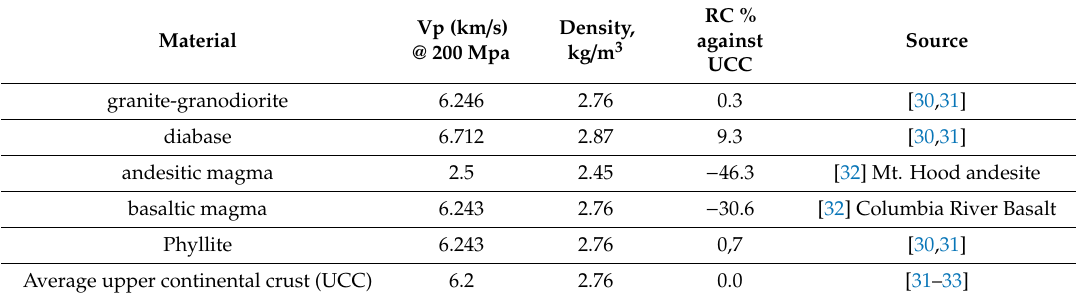
Table 1. Relevant physical properties of representative materials. The velocity measurements correspond to 200 MPa and the magma measurements correspond to 2000 ◦